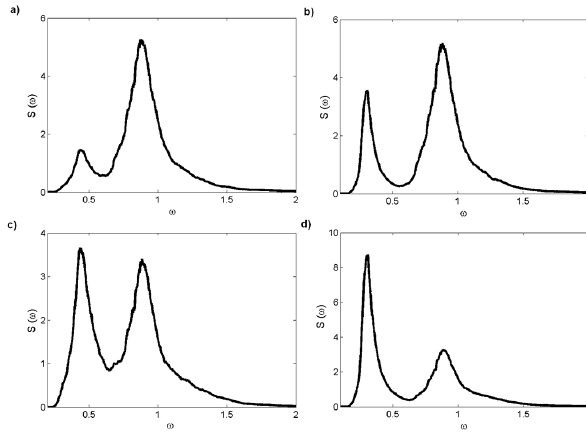
Figure 2. Wave spectra at the first probe for mixed following seas: